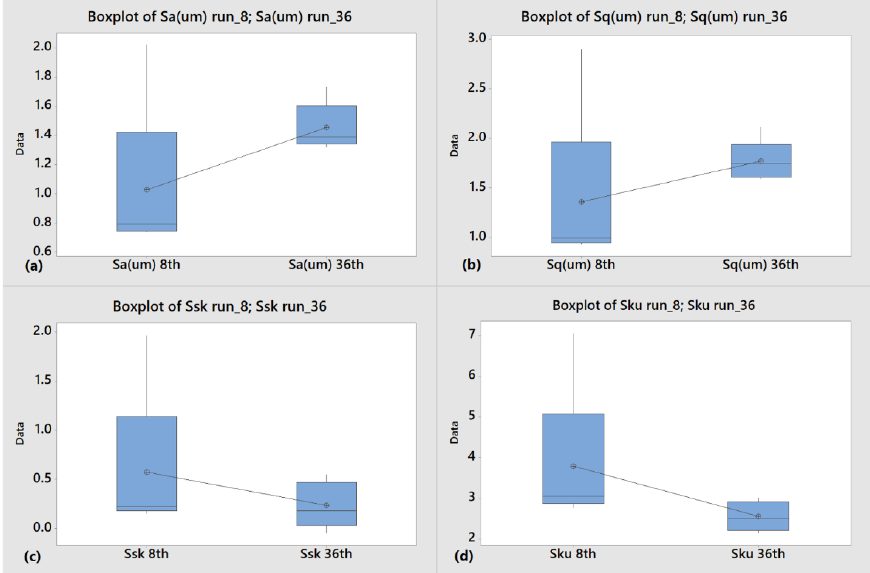
Figure 8. Box plots of ( a ) Sa, ( b ) Sq, ( c ) Sku, and ( d ) Ssk for run_8 and